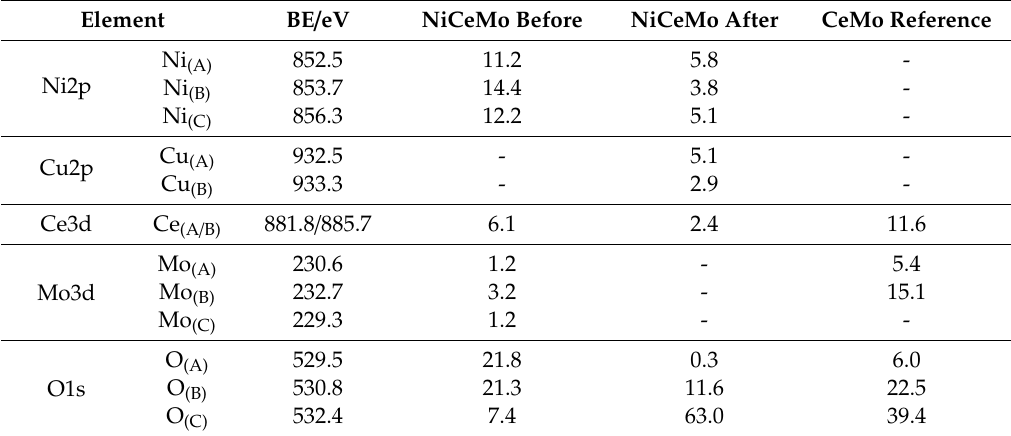
Table 4. Spectral deconvolution performed for composite Ni